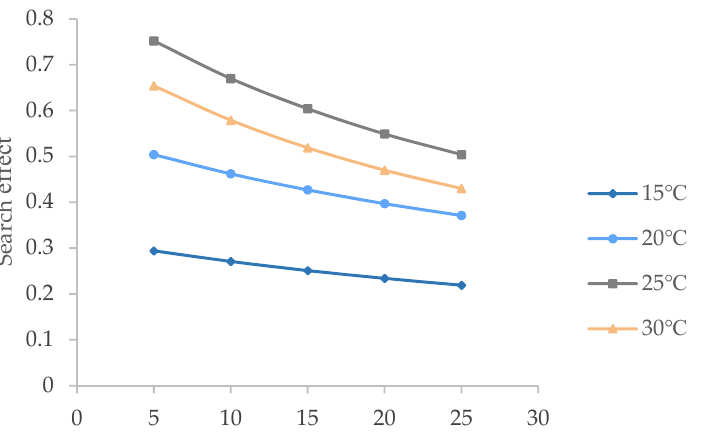
Figure 4. Searching effect of O. sauteri adults on adult tea thrips at different temperatures.